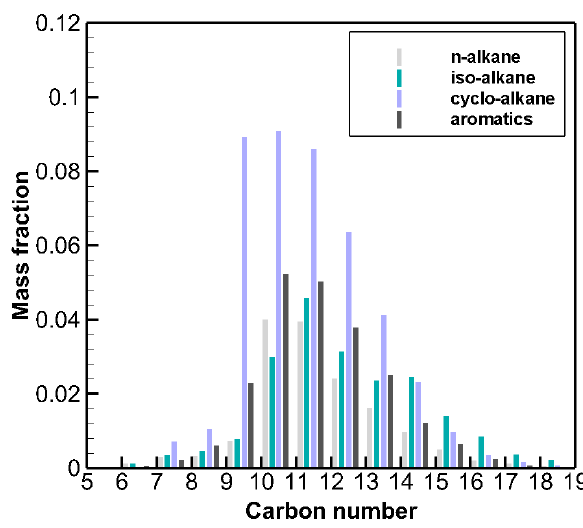
Figure 10. Detailed fuel composition of a typical crude oil-based Jet A-1.